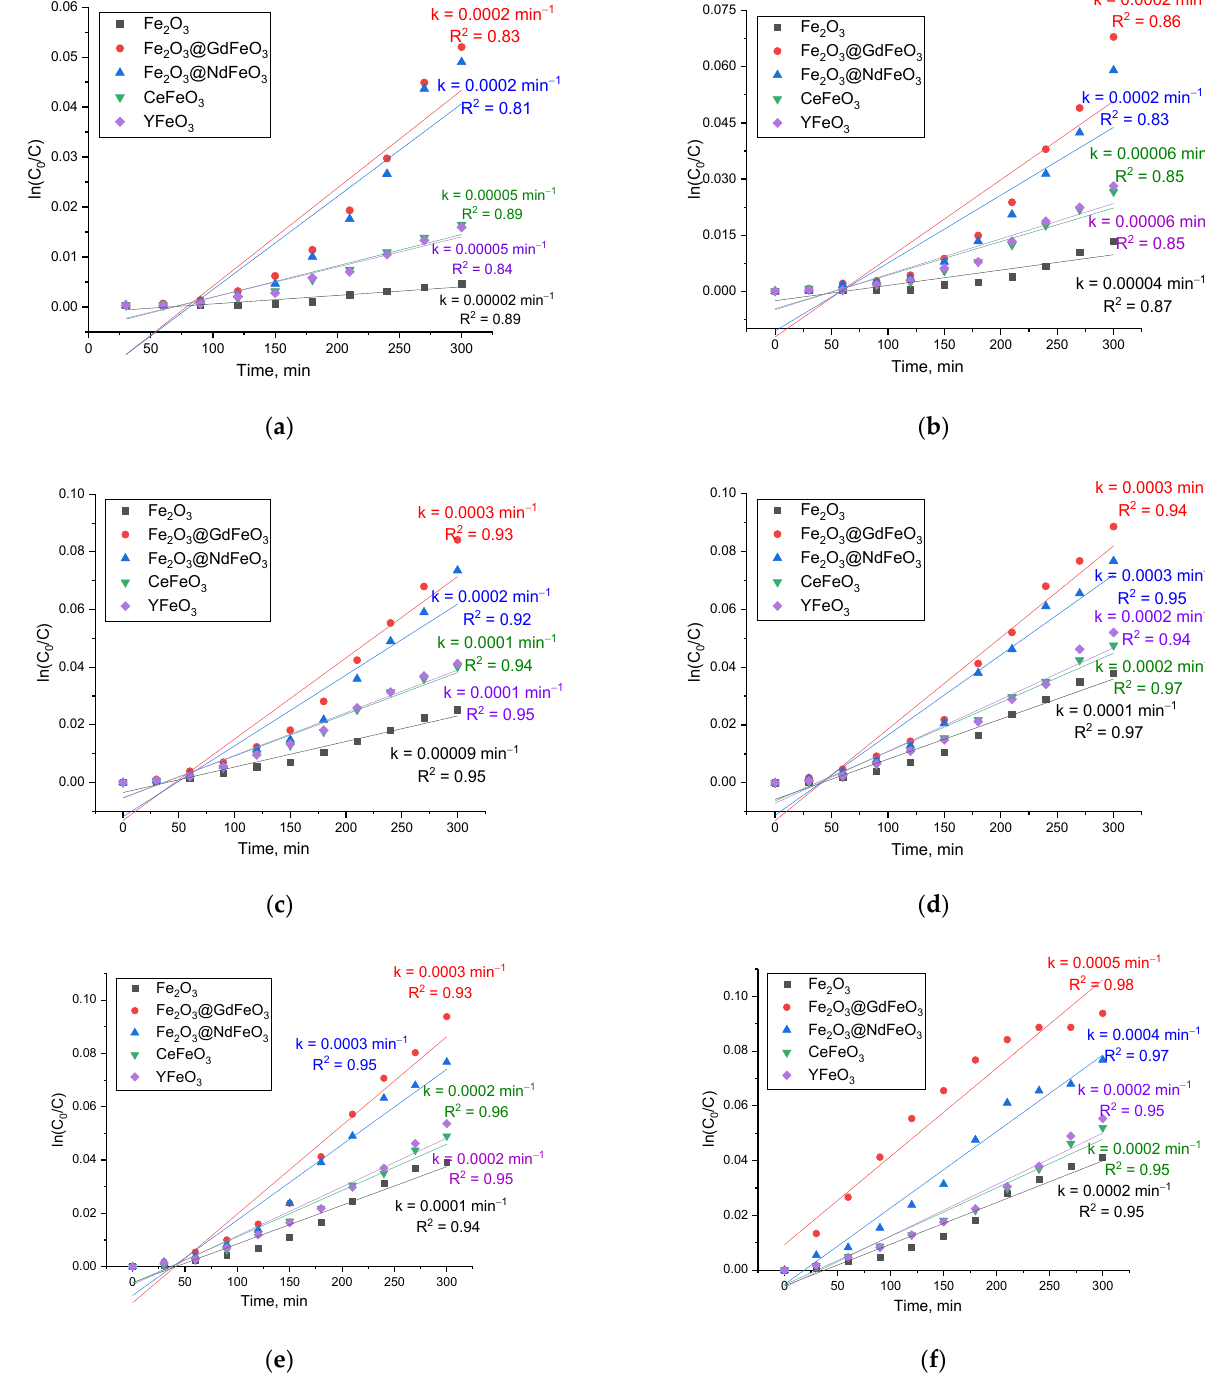
Figure 7. Results of the construction of adsorption reaction kinetic curves in order to determine the reaction rate constant for the studied nanoparticles with a variation in their mass in solution: ( a ) 0.01 g; ( b ) 0.05 g; ( c ) 0.10 g; ( d ) 0.25 g; ( e ) 0.50 g; ( f ) 1.00 g.